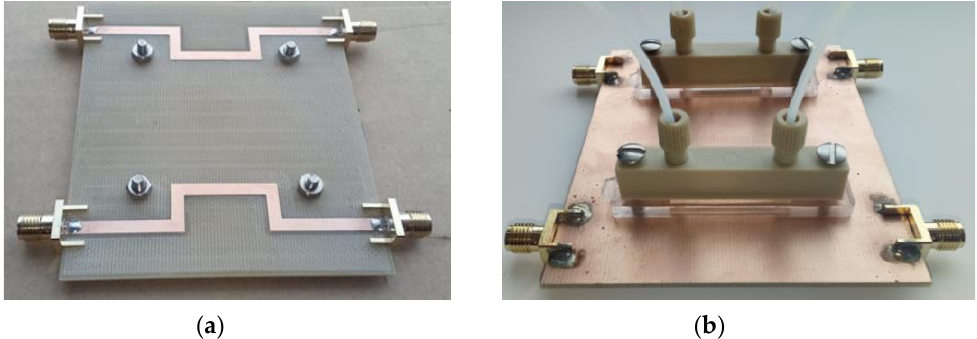
Figure 27. Perspective photographs of the CSRR-based differential sensor. ( a ) Top; ( b ) bottom. From [66], reprinted with permission.